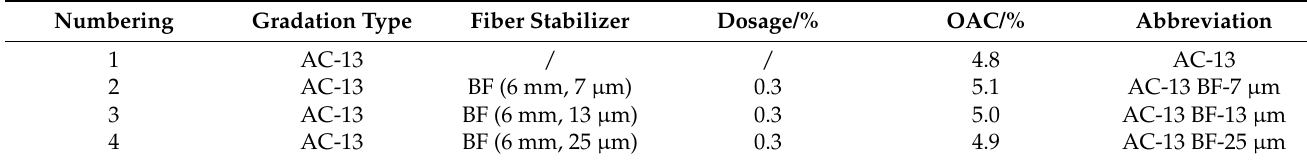
Table 3. AC-13 asphalt mixture component material.